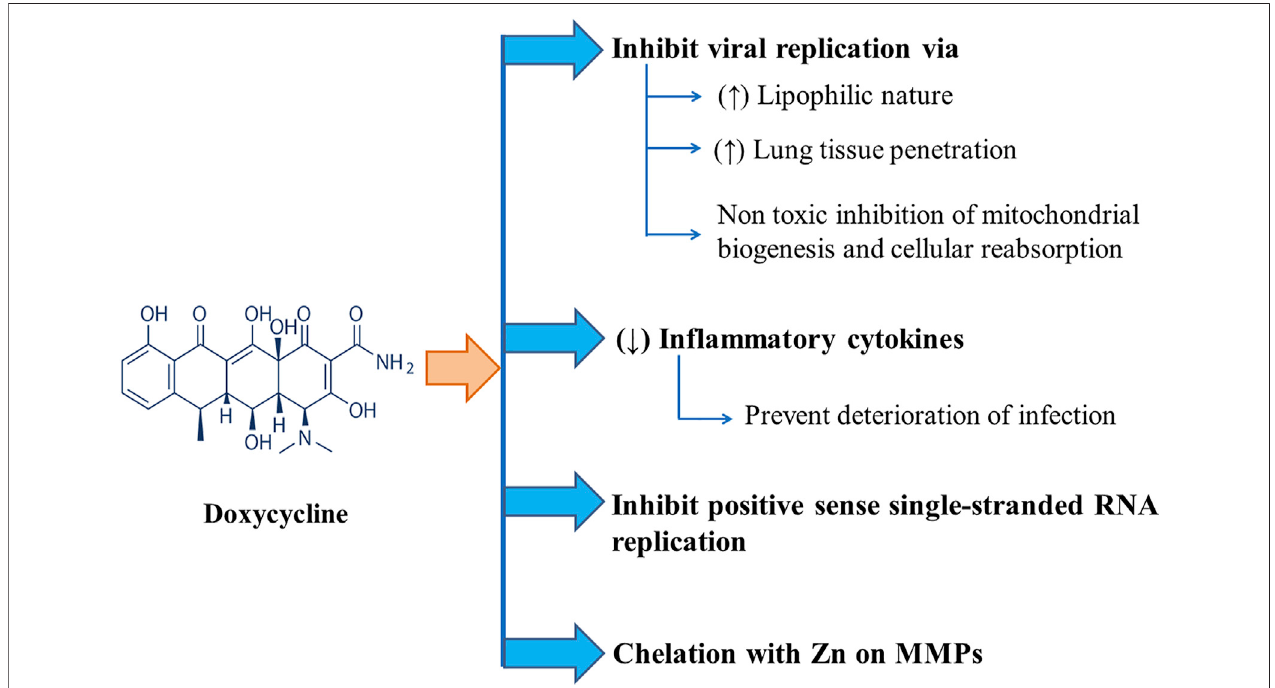
FIGURE 2 | Different modes of Anti-COVID-19 actions of Doxycycline including inhibition of viral replication and positive sense single-stranded RNA replication along with chelation with Zn on MMPs and downregulation of in fl ammatory cytokines.